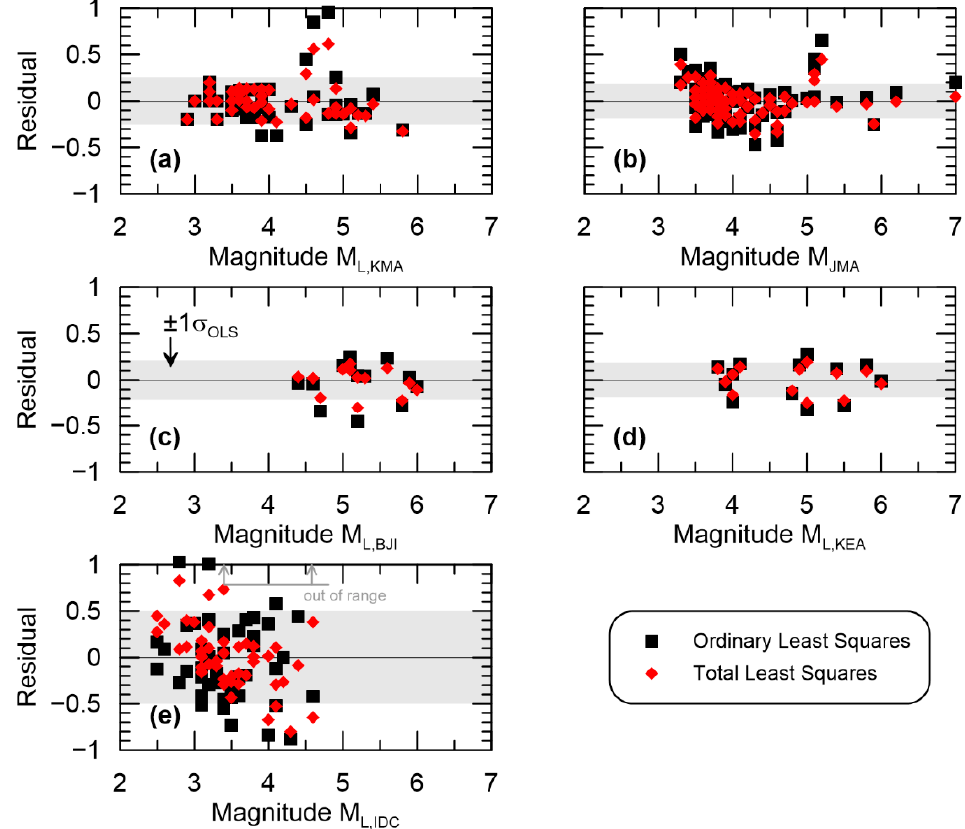
Figure 8. Regression residuals for M L from ( a ) KMA, ( b ) JMA, ( c ) BJI, ( d ) KEA, and ( e ) IDC. The shaded regions represent ±1 σ from OLS regression.